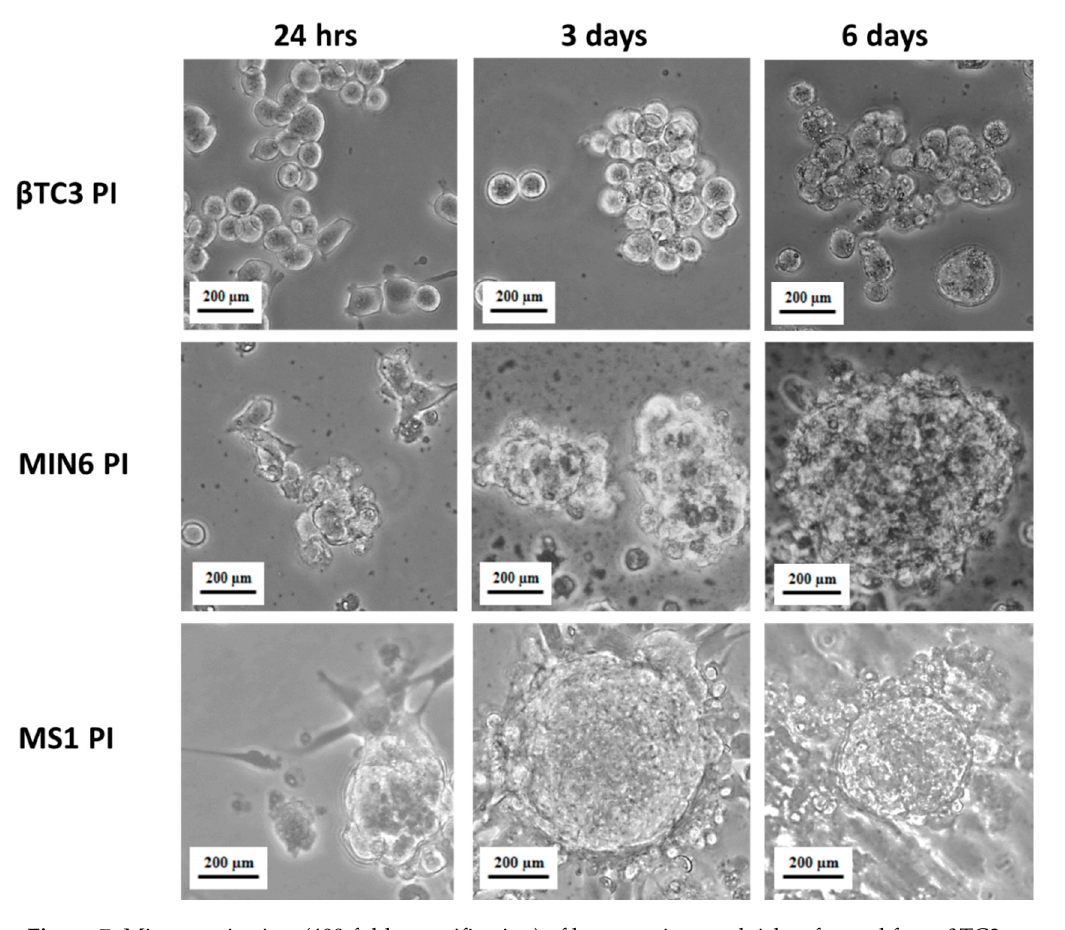
Figure 7. Microscopic view (400-fold magnification) of homotypic pseudoislets formed from β TC3 or MIN6 insulinoma cells or MS1 pancreatic endothelial cells after 24 h, three and six days of co-culture.